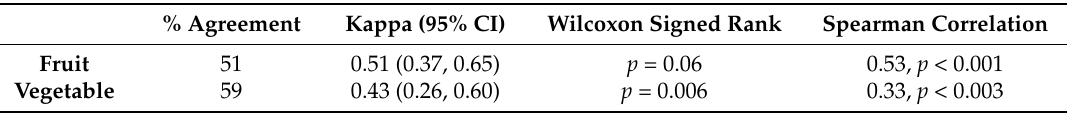
Table 2. Comparisons between the FWQ and 24hDR by counts of fruits and vegetables among 8 to 12 years old ( n = 82).